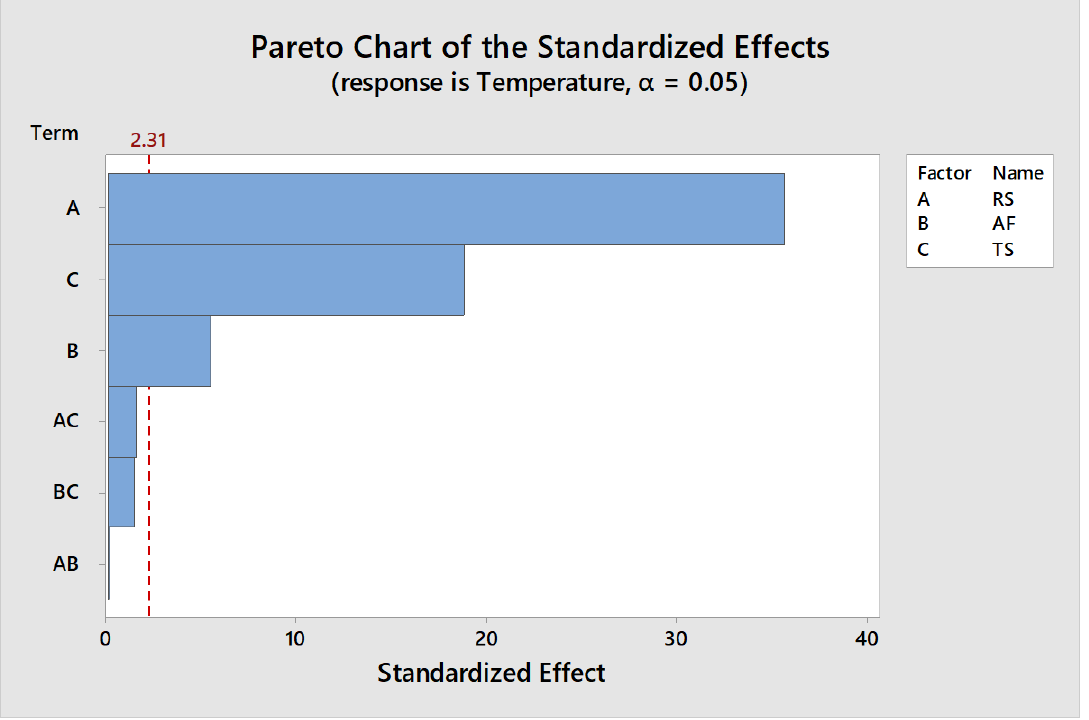
Figure 28. Pareto chart — temperature.